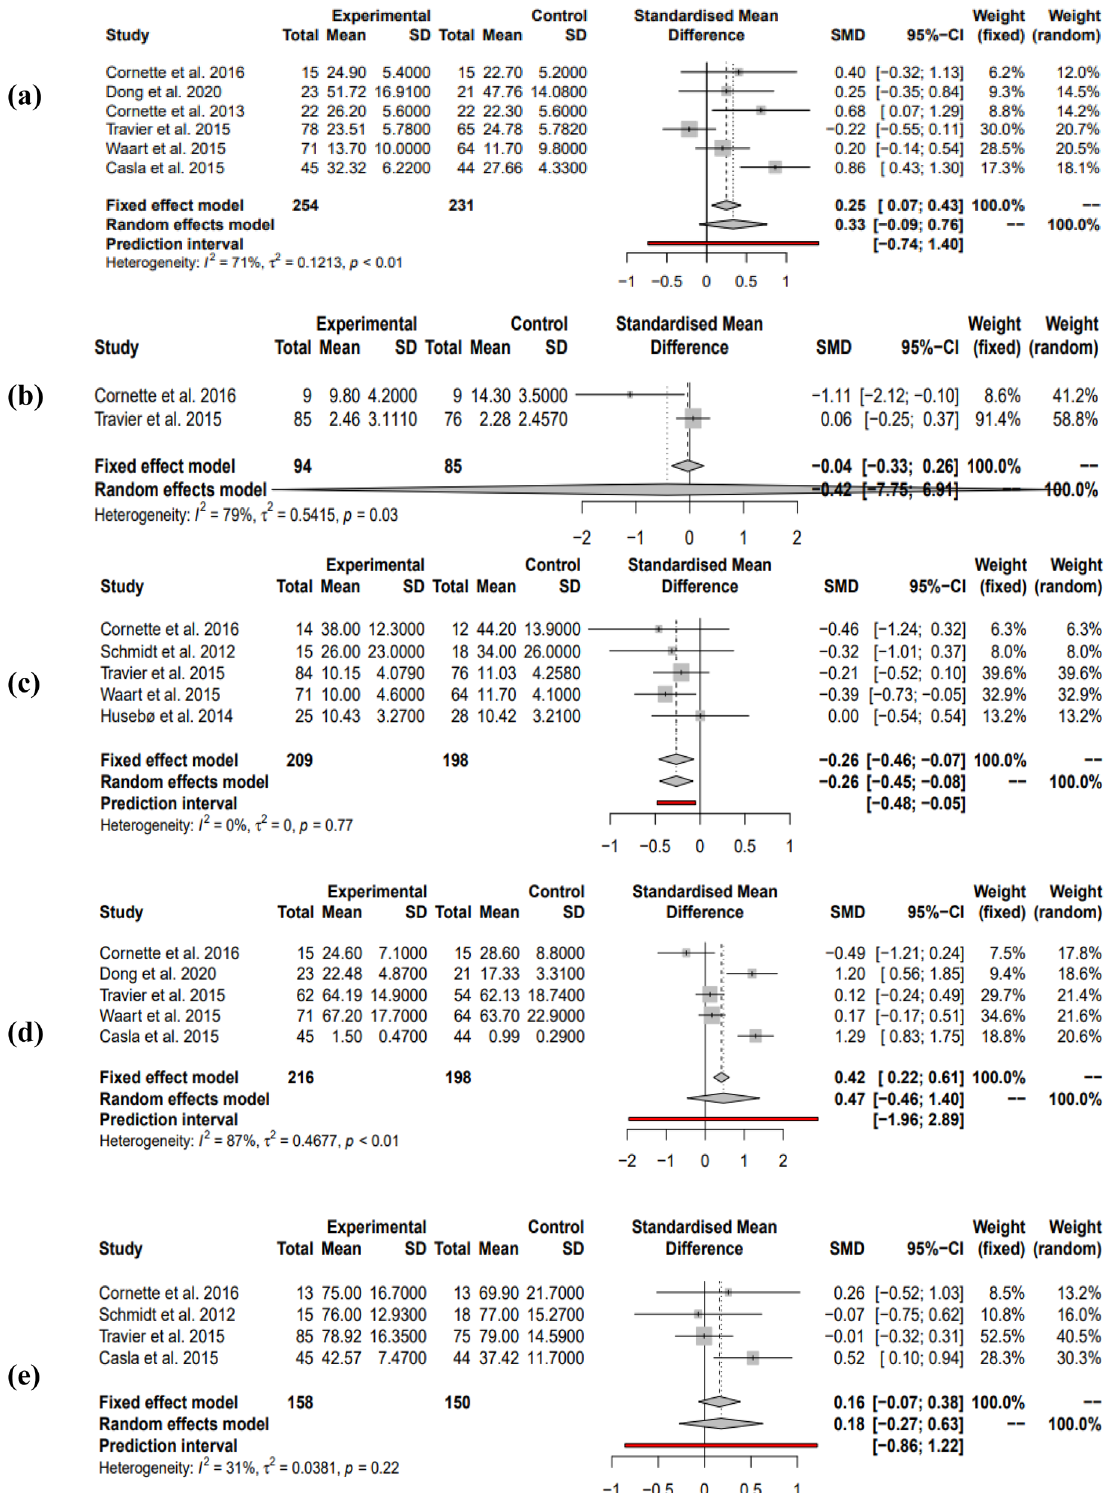
Figure 5. Random effects models showing the effects of combined resistance and endurance interventions on ( a ) cardiorespiratory fitness, ( b ) depression, ( d ) muscular strength, ( e ) QOL during adjuvant treatment. Fixed effects model showing the effects of combined resistance and endurance interventions on ( c ) global fatigue during adjuvant treatment. Positive effect sizes favour the exercise intervention in ( a,d,e ). Negative effect sizes favour the exercise intervention in ( b,c